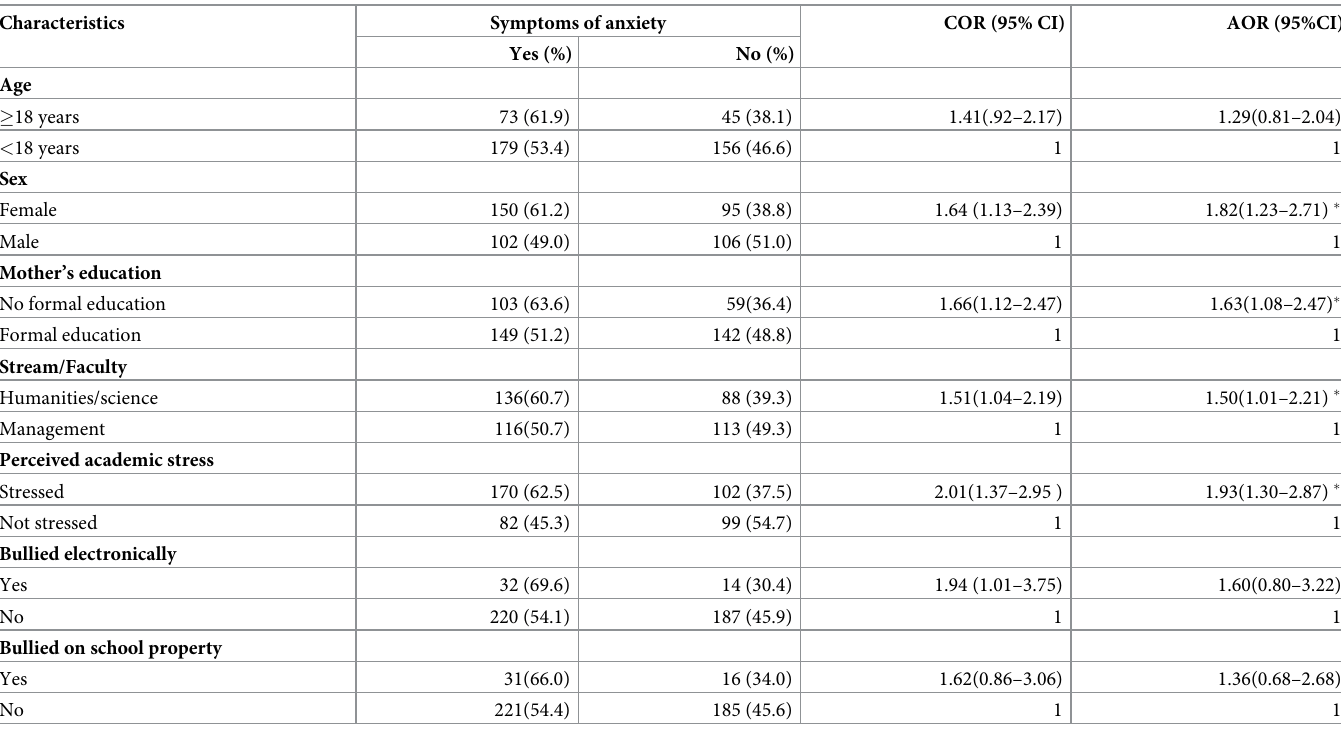
Table 5. Factors associated with symptoms of anxiety among high school students of an urban municipality in Kathmandu (n = 453).